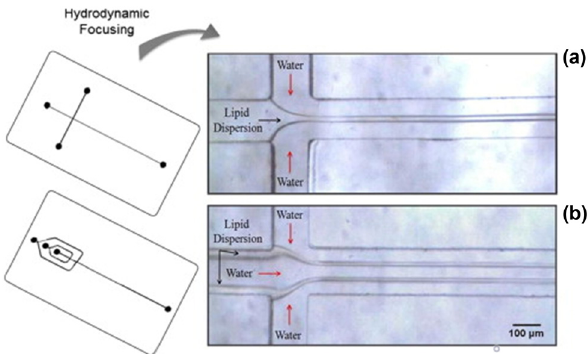
Figure 7: Schematic and photography of the micro fl uidic devices developed in ref. [ 59 ] depicting the single ( a ) and double ( b ) hydrodynamic focusing. Lipids are diluted in ethanol and injected in the center channel with a fl ow velocity of 143 mm/s. Deionized water fl ows through the exterior channels to hydrodynamically compress the central fl ow. In the case of double focusing, another fl ow - focusing stream is added to each side. Image reproduced with permission from Chemical Engineering Journal [ 59 ]